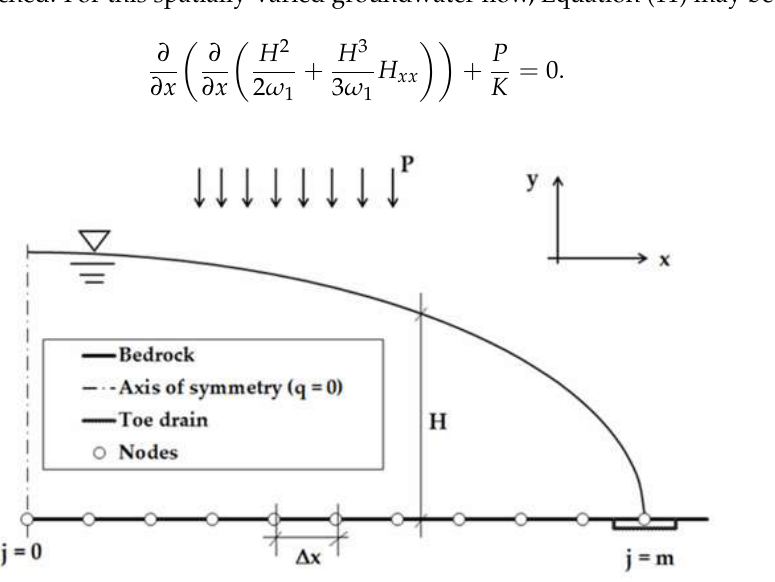
Figure 9. Variation of the relative curvature of the bedrock profile in the streamwise direction.